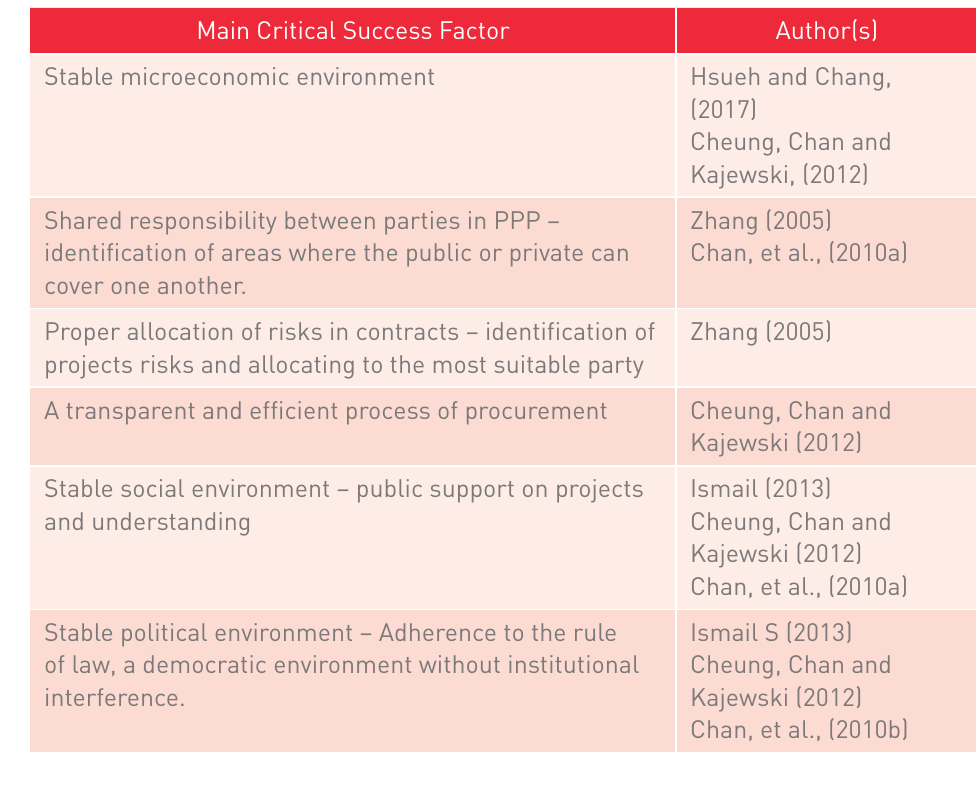
Summary of Critical Success factors of PPP